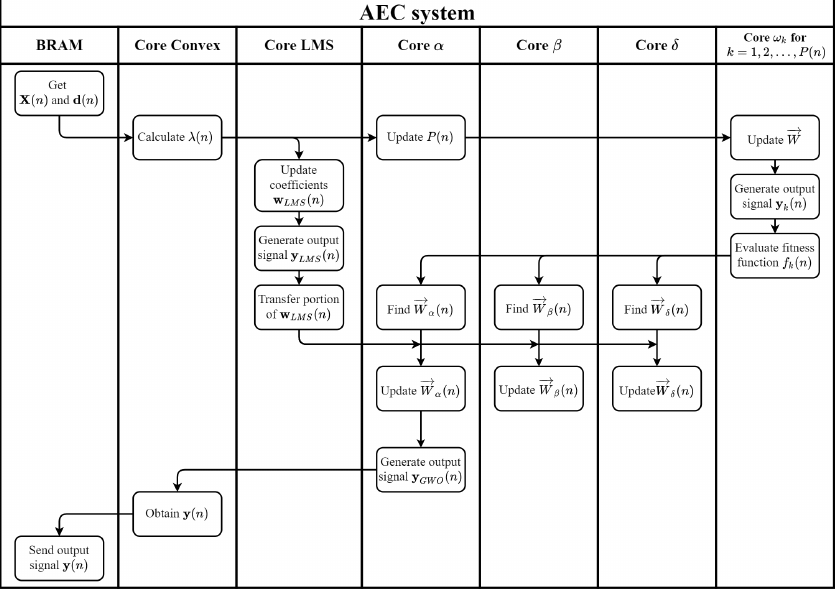
Figure 13. The sequential diagram to describe how the proposed convex GWO/LMS adaptive filter is executed by means of the processing